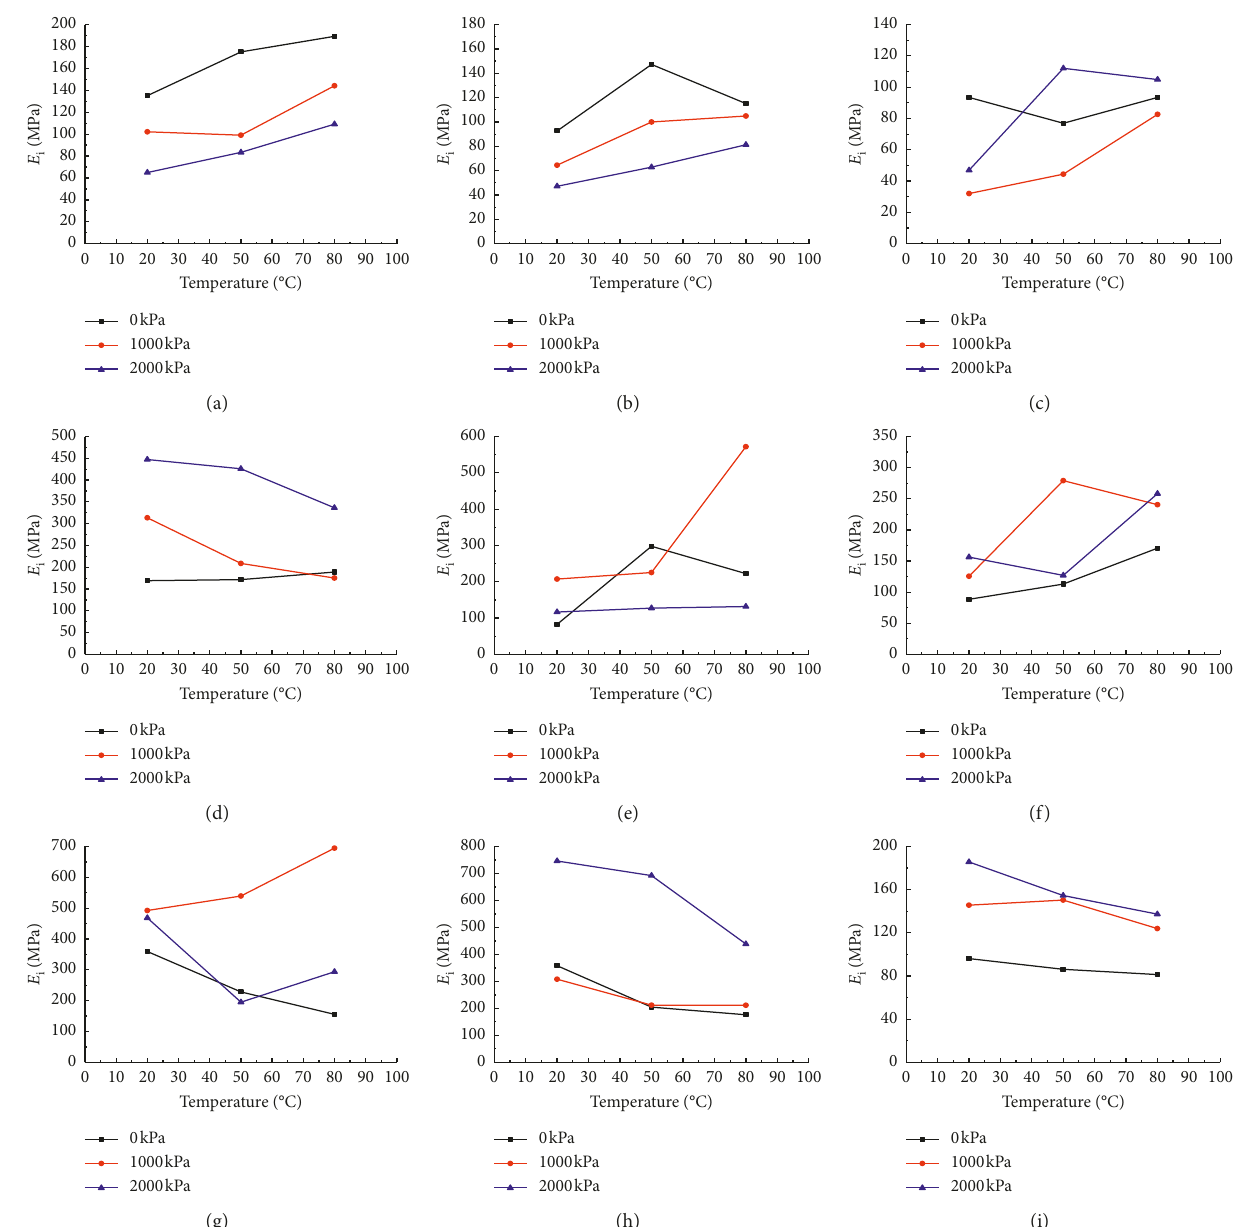
Figure 10: The relationship curves of Young’s modulus changing with temperature under different water contents, dry densities, and confining pressures. (a) ρ 1.6g/cm 3 , w � 15%. (f) ρ